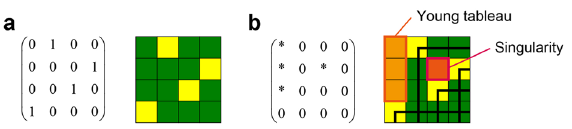
Figure 2. Schematic of an example of the Schubert matrix. ( a ) The permutation of [2431] is represented by a matrix S in Eq. (2). ( b ) The diagram of the matrix S is illustrated. The upper-left block consisting of ∗ s (indicated by orange squares) is called the Young tableau , whereas isolated ∗ blocks are called singularities .